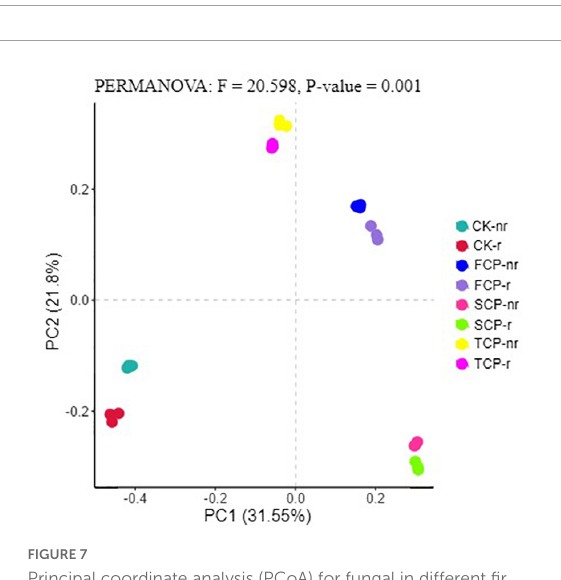
FIGURE7 Principal coordinate analysis (PCoA) for fungal in different fir seedings and soil types (using combined rhizosphere soil and bulk soil data). Data were obtained from different successive planting generations and soil types CK, Nanmu seedings; FCP, first generation seedings; SCP, second-generation seedings; TCP, third-generation seedings; r, rhizosphere soil; nr, bulk